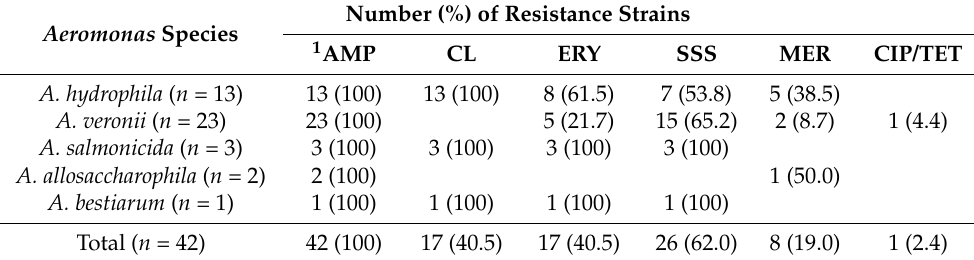
Table 5. Range of resistance to the antimicrobials tested. Number (%) of Resistance Aeromonas Species